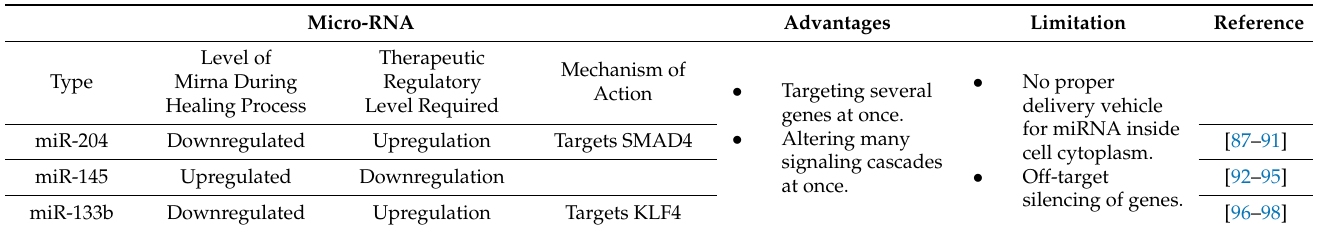
Table 3. MicroRNAs as therapeutic tools in reviving a cornea without scarring. Micro-RNA